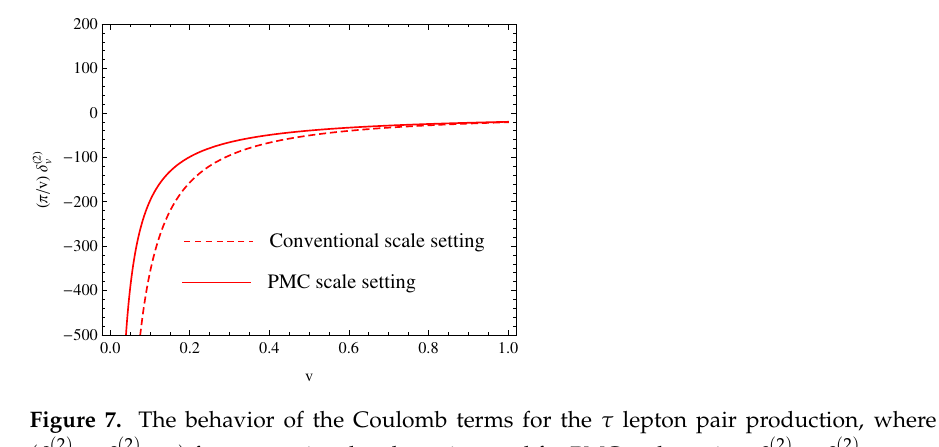
Figure 7. The behavior of the Coulomb terms for the τ lepton pair production, where δ ( δ ( 2 ) + δ ( 2 ) ) for conventional scale setting, and for PMC scale setting, δ ( 2 ) v , n f n f v , in